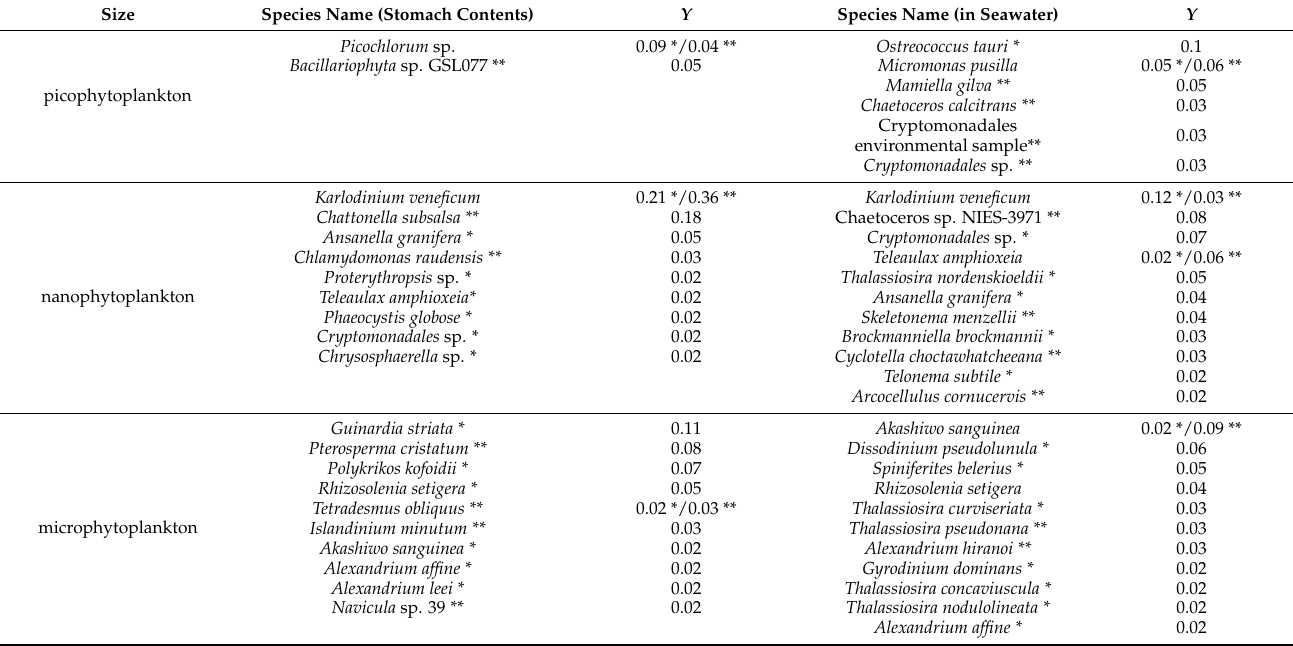
Table 3. Dominant species of phytoplankton of different sizes in the stomach contents of R. philip- pinarum and water of the Yalu River Estuary in